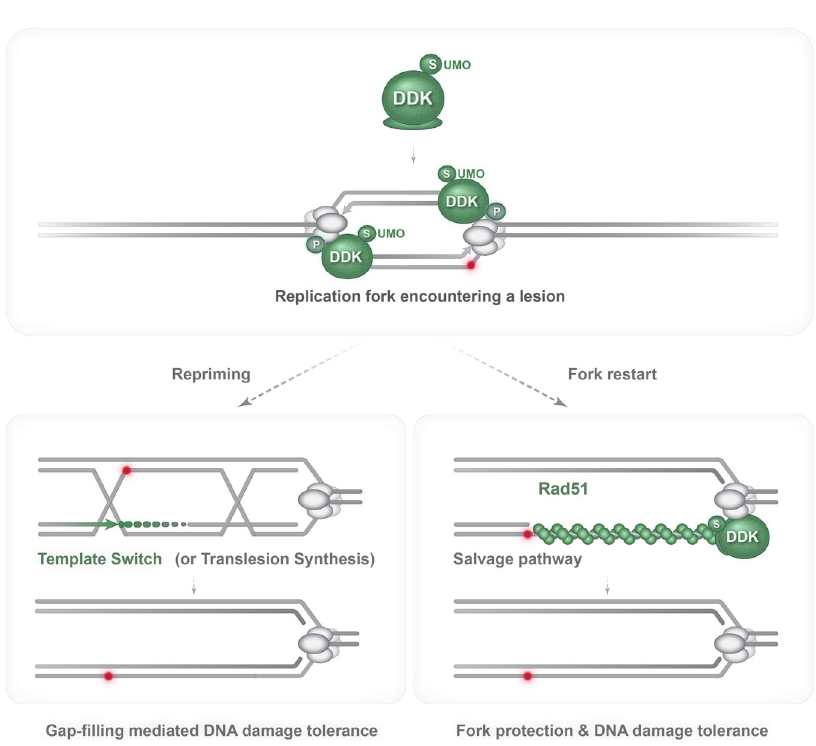
Fig. 7 Model illustrating SUMOylated DDK kinase as regulator of gap- fi lling mediated DNA damage tolerance and fork restart by recombination. The model illustrates monoSUMOylated DDK kinase traveling with replication forks exposed to genotoxic stress. SUMOylated DDK kinase prevents fork uncoupling and stabilizes Rad51 fi laments on exposed ssDNA gaps. These fi laments may facilitate repriming creating additional substrates for gap- fi lling in addition to the ones generated on the lagging strand by physiological repriming events. Alternatively, Rad51 assembly on ssDNA stretches at stalled replication fork can be engaged by salvage recombination pathways with potential to generate genome rearrangements. MonoSUMOylated DDK kinase facilitates both recombination-mediated gap- fi lling and DNA damage tolerance/fork protection in the context of the stalled replication fork. the indicated timepoints in the presence of 1% sodium azide and incubated in ice for 30min. Cells were pelleted and washed with ice-cold 1X TE buffer. Genomic DNA with ice-cold 1X TE. The beads are then resuspended in 50 μ l of elution buffer was extracted using the genomic DNA extraction kit (QIAGEN) according to (50mM Tris-HCl pH8, 10mM EDTA, 1% SDS); and then incubated at 65°C for manufacturer ’ s instructions. BrdU immunoprecipitation was carried out as pre- 10min by shaking. After centrifugation and magnetic attachment, the supernatant viously described in Bermejo et al. 80 . The BrdU containing DNA is sheared to was transferred into new tubes. In all, 49 μ l of 1X TE buffer and 1ml of Proteinase K 200 – 1000bp fragments by sonication using the Bandelin UW2070 sonicator (stock 50mg/mL) was added to both IP and input tubes. The tubes were then mixed (5 sonication cycles, 20% power, 15s/pulse). After each sonication cycle, the chro- without vortexing and were incubated at least 2h at 37°C. The DNA from this matin was pelleted by centrifuging at 2300g for 1min at 4°C. Towards the end of sonication, sheared DNA was centrifuged for 5min at 3000rpm at 4°C. The sheared genomic DNA was denatured at 100°C for 10min and immediately plunged into ice and were later supplemented with 100 μ L of ice-cold PBS 2x and 200 μ L of ice cold- PBS with 2% 1x BSA and 0.2% Tween20. BrdU immunoprecipitation was carried out overnight by adding the genomic DNA into 10 μ L of Protein A-magnetic Dynabeads (Thermo fi sher) and 4 μ g of anti-BrdU antibody (clone 2B1, MBL, MI-11-3). 10ml of DNA solution was kept as input. Next day, after immuno-precipitation, beads were 2D gel electrophoresis . Exponential cells were arrested in G1 phase using alpha washed two times with ice-cold lysis buffer (50mM HEPES-KOH pH7.5, 140mM factor and synchronously released from G1 phase in 0.033% MMS containing YPD NaCl, 1mM EDTA, 1% Triton x100, 0.1% Na-deoxycholate), two times with ice-cold NATURE COMMUNICATIONS| (2022) 13:2480